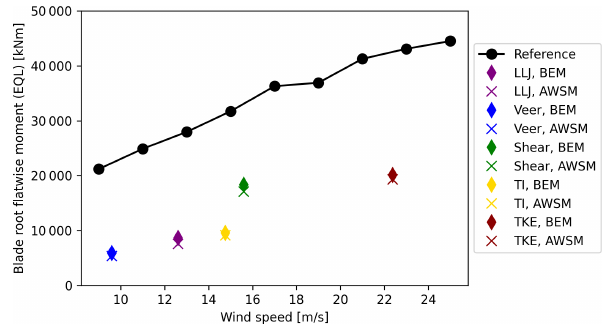
Figure 9. Equivalent blade root flatwise moment: DLC 1.2 versus GRASP extreme wind events.